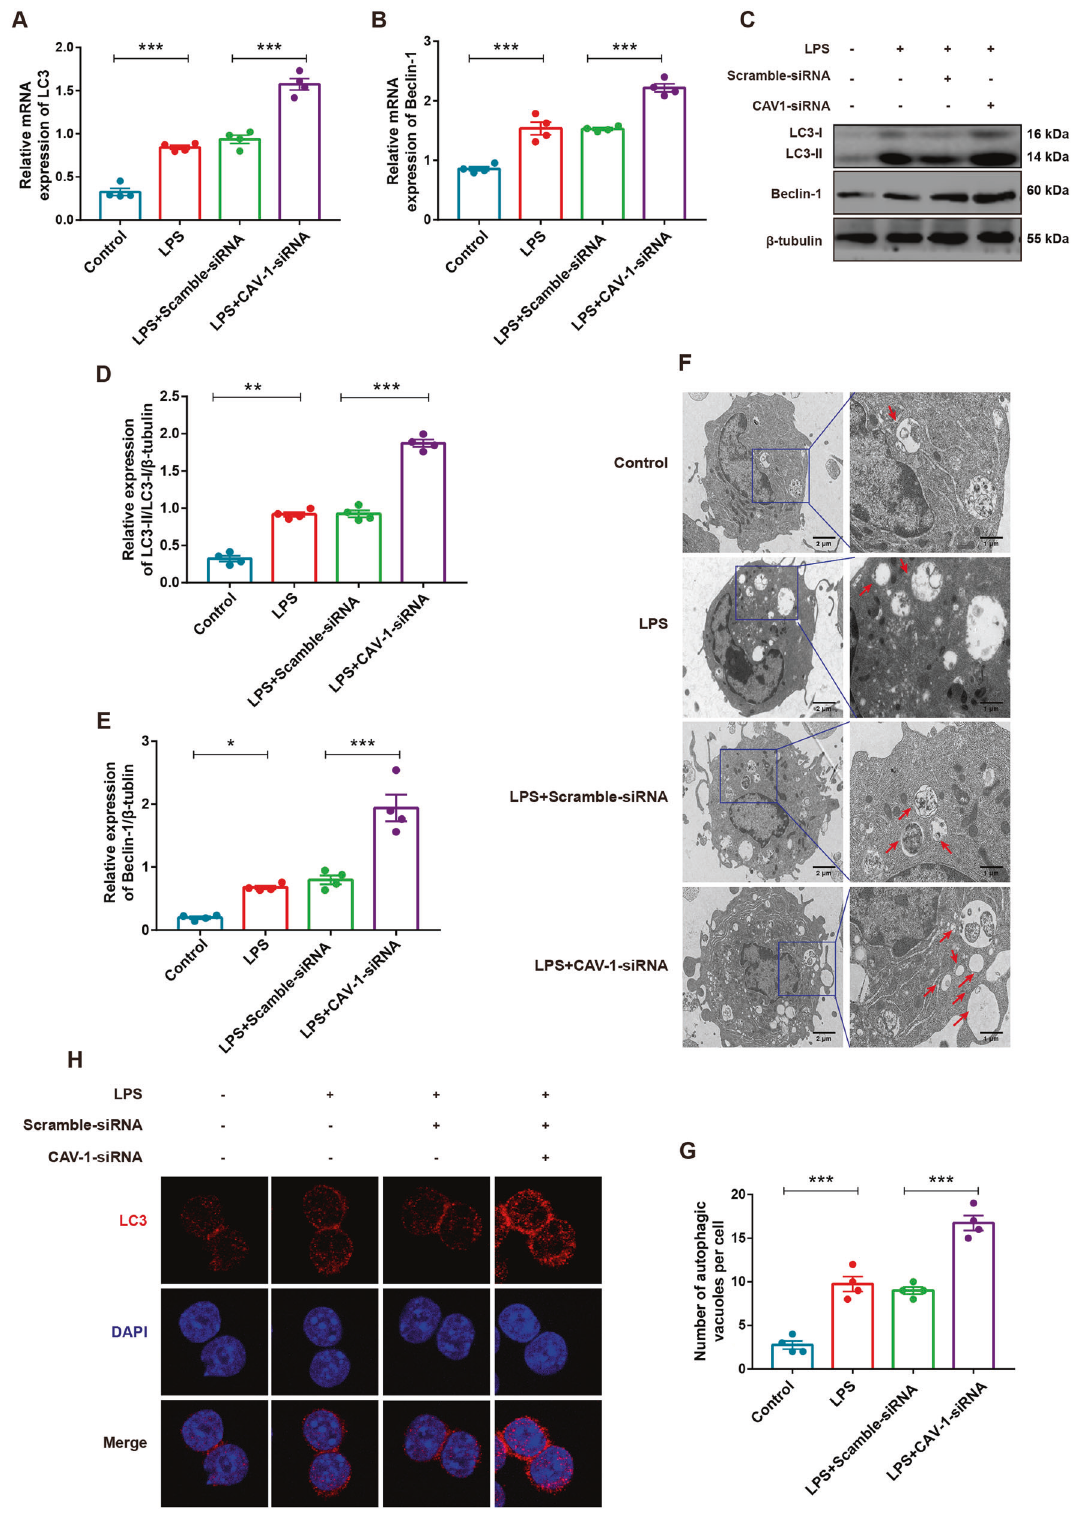
Fig. 6 Knockdown of CAV-1 activated autophagy in BMDMs. A , B The mRNA levels of LC3 and Beclin-1 by qRT-PCR in BMDMs. C The protein expression of LC3II/I and Beclin-1 were assessed by western blotting in BMDMs. D , E Quanti fi cation of LC3 and beclin-1 expression. F The formation of autophagosomes in different groups of BMDMs was observed by TEM. Red arrows indicate autophagosomes. G Quantitative analysis of BMDMs autophagosomes number in each group. H Immuno fl uorescence analysis of LC3 (red) expression in BMDMs (magni fi cation ×63). Results were represented as mean ± SEM ( n = 4, * p < 0.05, ** p < 0.01, *** p <